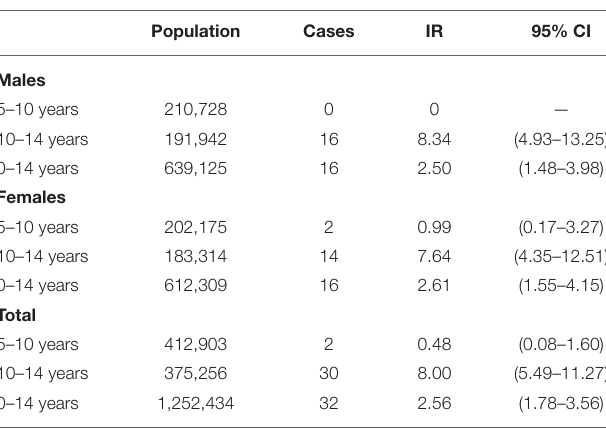
TABLE 2 | Baseline characteristics of Kuwaiti children and adolescents diagnosed with T2D between 2011 and